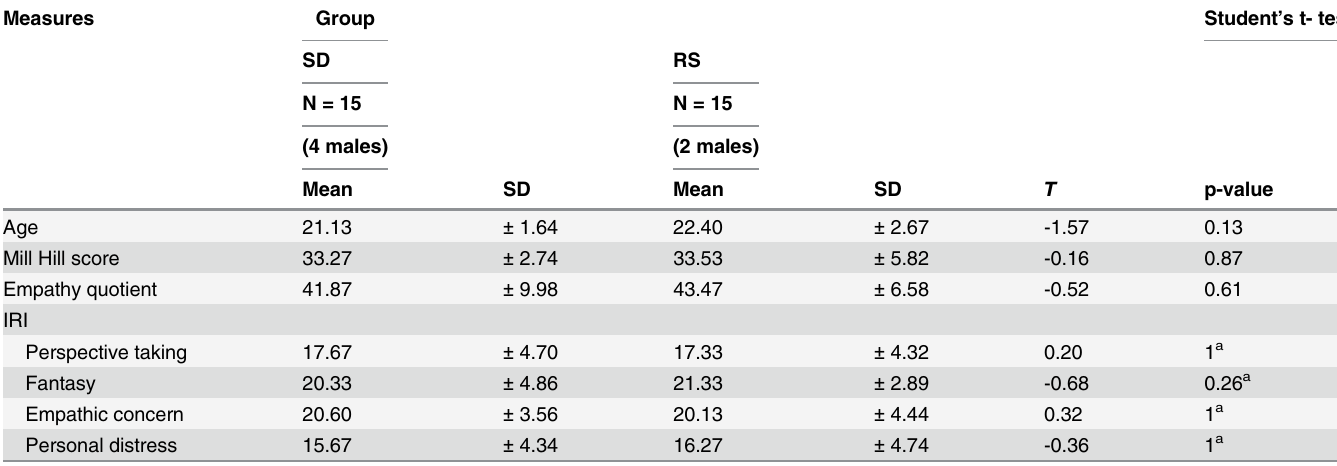
Table 1. Means, standard deviations and group